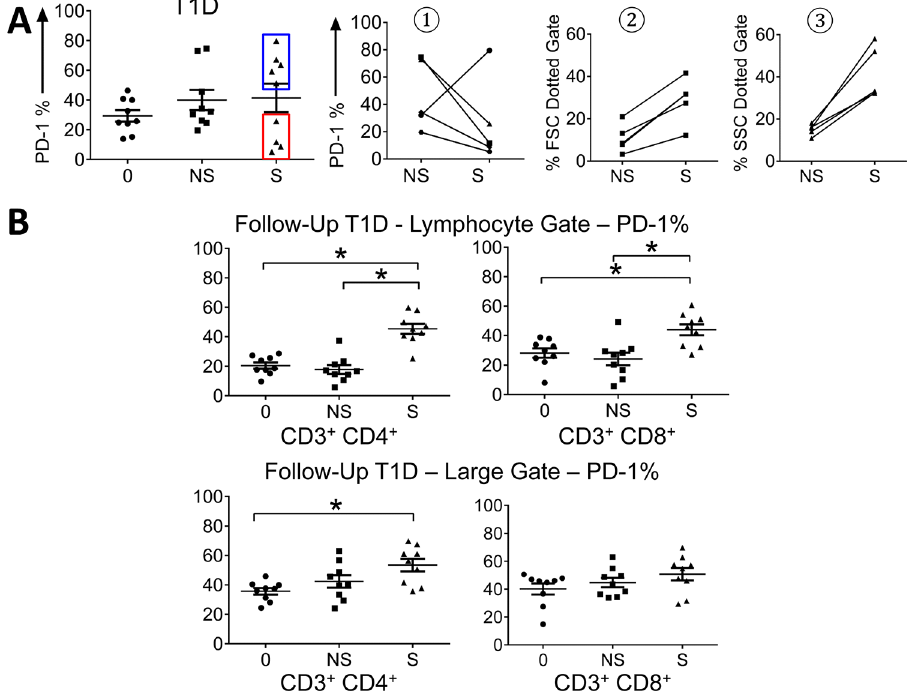
Fig 2. PD-1 expression recoversin T1D follow up. A . Subpopulationsof T cells, one that down regulates PD-1 and the other that upregulatesPD-1 B . Expression of PD-1 in T cells from T1D after 4–6 months post diagnosis (T1D Follow up) ( * indicatep < 0.05). Top left CD3 + CD4 + lymphocyte gate, top right CD3 + CD8 + lymphocyte gate, bottom left CD3 + CD4 + large gate, and bottom right CD3 + CD8 + large gate.